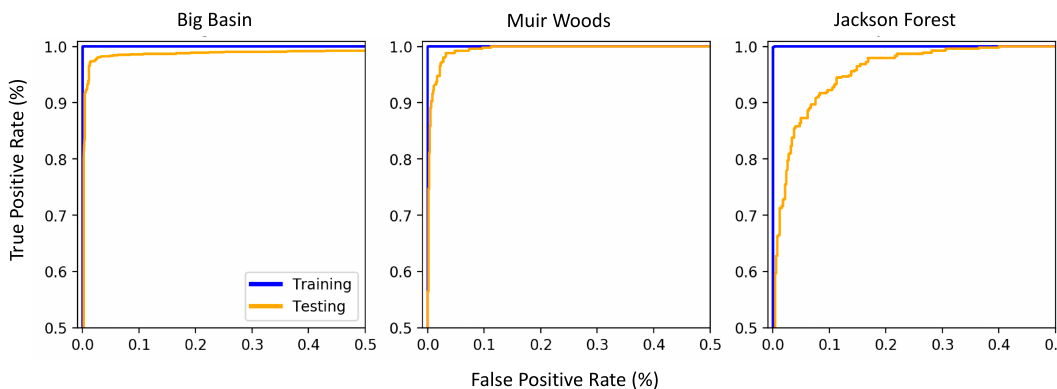
Figure 4. Receiver operating characteristic curves for the final model for each site. Each point along the line is the true positive rate and false positive rate calculated when setting a distinct threshold value between zero and one, above which the pixel is classified as a redwood and below which it is classified as another species. Blue lines show the model performance evaluated on the training dataset and orange lines show the model performance evaluated on the testing dataset. Table 4. Four measures of model performance on the testing and the training datasets at all three sites. Training Testing